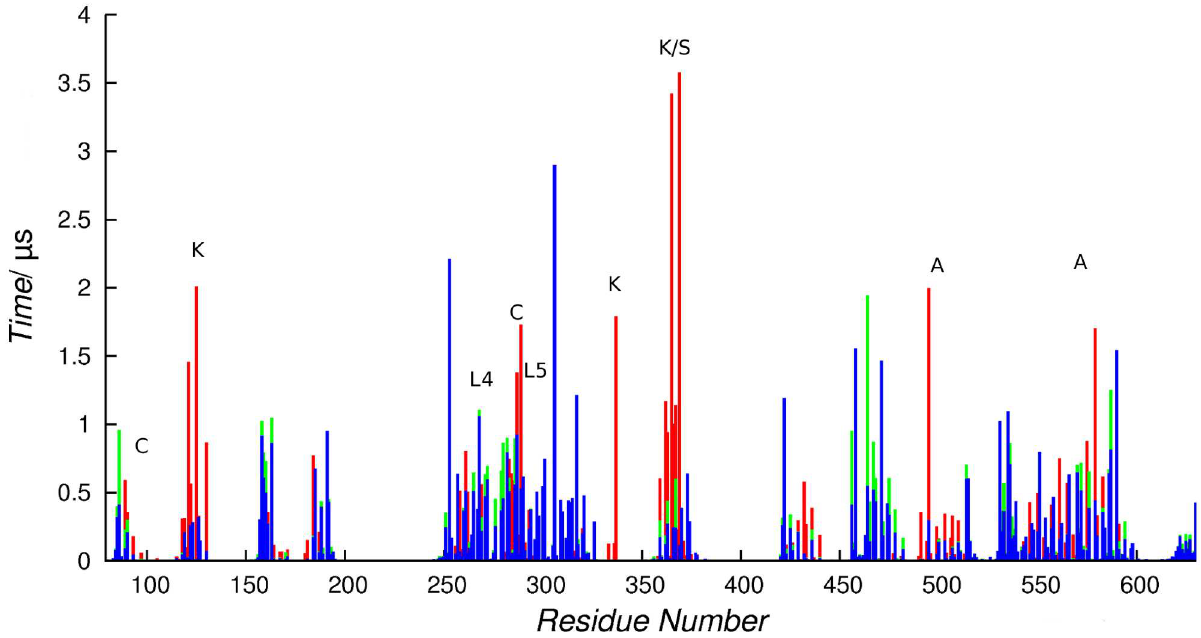
Fig 10. Maximum occupancy times for all lipids. DSPC (blue), POPE (green)and cholesterol (red); values were obtainedaveraging values collectedin SYS3.1–2. Sites regions along the sequenceare indicatedby the corresponding